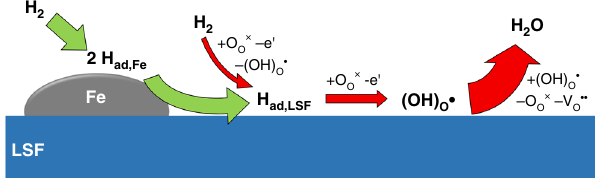
Fig. 8 Sketch of the proposed mechanism for the case of H 2 oxidation. Reaction steps with red arrows proceed on the La 0.6 Sr 0.4 FeO 3- δ surface, those with green arrows require the metallic iron particles. The thicknesses of the arrows are a qualitative indication for the respective